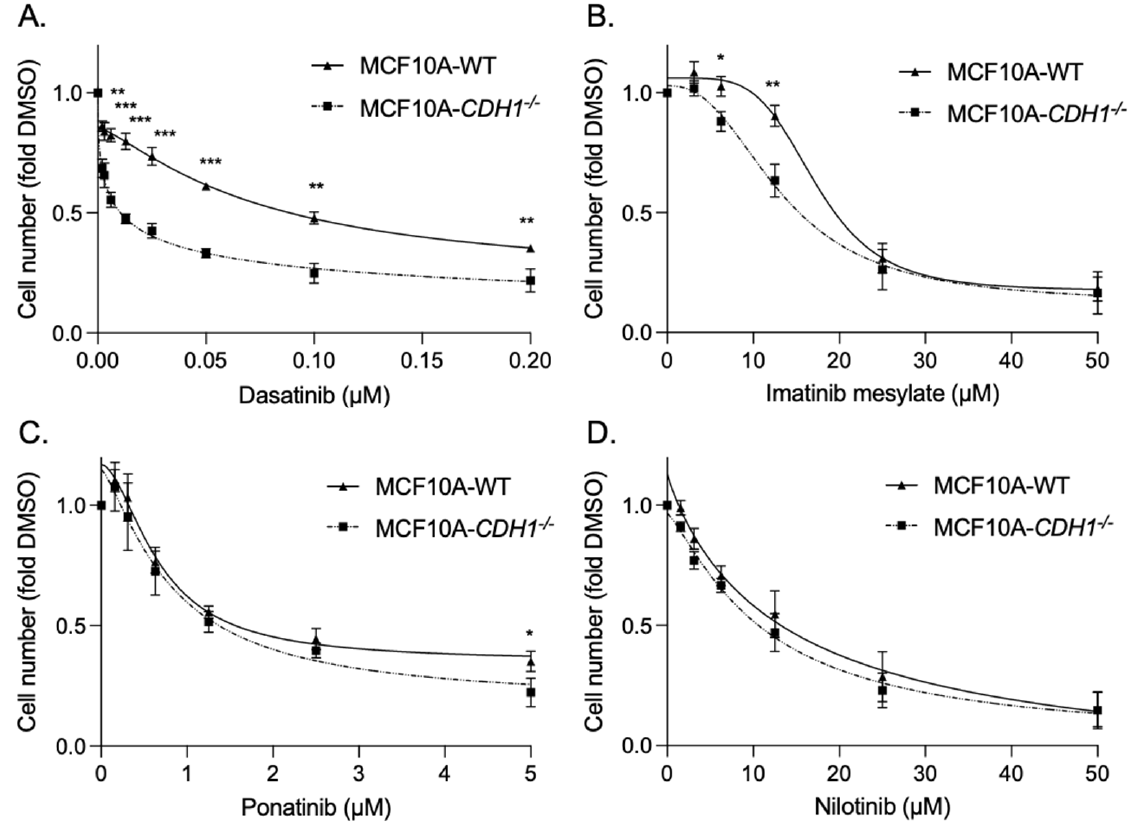
Figure 1. Mammary epithelial cells lacking CDH1 expression are preferentially sensitive to the cytotoxic effects of dasatinib. ( A – D ) Normalised MCF10a-WT and CDH1 − / − cell counts 48 h after treatment with serial dilutions of dasatinib ( A ), imatinib mesylate ( B ), ponatinib ( C ) and nilotinib ( D ). Wild-type, black bars, CDH1 − / − grey bars. Six fields per well at 4 × magnification were captured using the Cytation 5 imager (Biotek). Nuclei were counted using Gen5 (Biotek) and normalised to the vehicle control for each cell line. (For all graphs, error bars = SEM; * p < 0.05, ** p < 0.01 and *** p <0.001; n ≥ 3 independent biological replicates; unpaired two-sided t -test) .